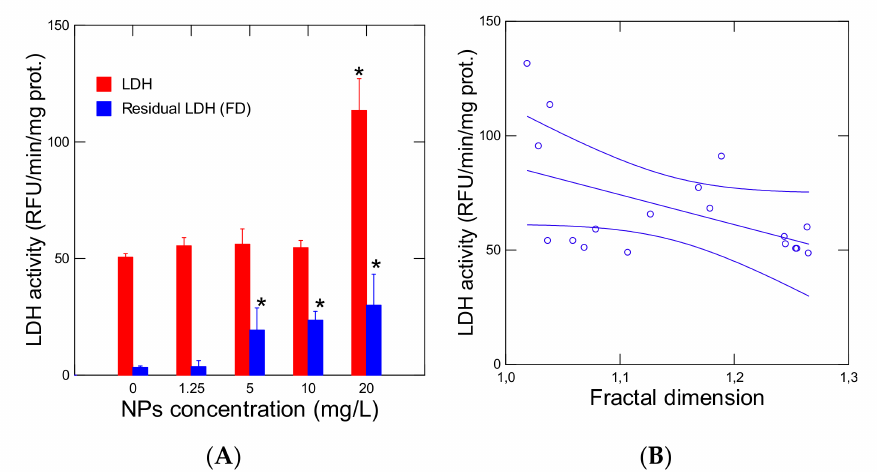
Figure 4. LDH activity and fractal dimension of LDH activity from Hydra exposed to NPs. Hydra were exposed to 50 nm NPs for 96 and analyzed for LDH activity ( A ) and the correlation with the fractal dimension (fD) ( B ). The data represents the mean with the standard error for N = 9 individuals per treatment. The star symbol * indicates significance from controls. * p <